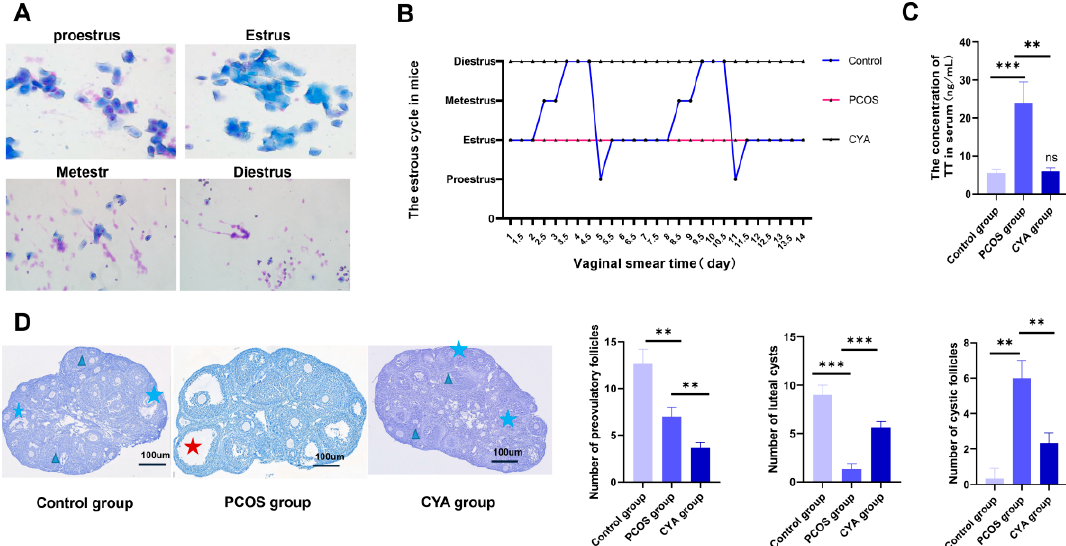
Figure 2. Three groups of mice were successfully constructed. ( A ) Schematic diagrams of vaginal smear in the three groups of mice (n = 5); ( B ) schematic diagrams of the estrus cycle in the three groups of mice (n = 5); ( C ) TT in serum was analyzed using enzyme-linked immunosorbent assay kits in the three groups of mice; ( D ) ovarian morphology in the three groups of mice was assessed with H&E staining, and ovulatory follicles, cystic follicles, and corpus luteum were counted; data are shown as mean ± SEM. “*” indicates represents comparison between groups, “ns” indicated that there was no statistical difference between the treatment group and the control group. * p < 0.05,